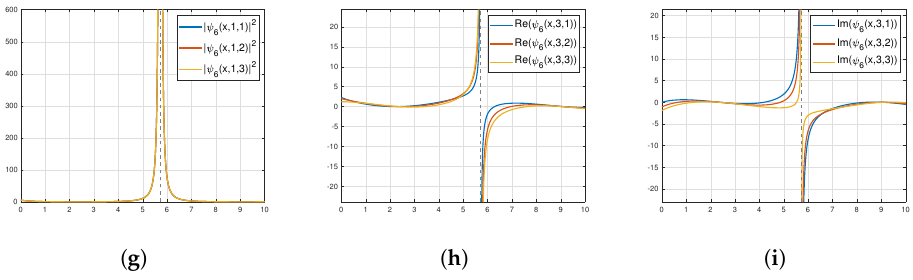
Figure 3. 3D plots of ψ 6 ( x ,3, t ) in Equation (29): ( a ) the graph of the square of the modulus; ( b ) the graph of the real part; and ( c ) the graph of the imaginary part. Contour plots of ψ 6 ( x ,3, t ) in Equation (29): ( d ) the graph of the square of the modulus; ( e ) the graph of the real part; and ( f ) the graph of the imaginary part. 2D plots of ψ 6 ( x ,3, t ) in Equation (29): ( g ) the graph of the square of the modulus; ( h ) the graph of the real part; and ( i ) the graph of the imaginary part for p = 0.75, q = 0.5, and r = −